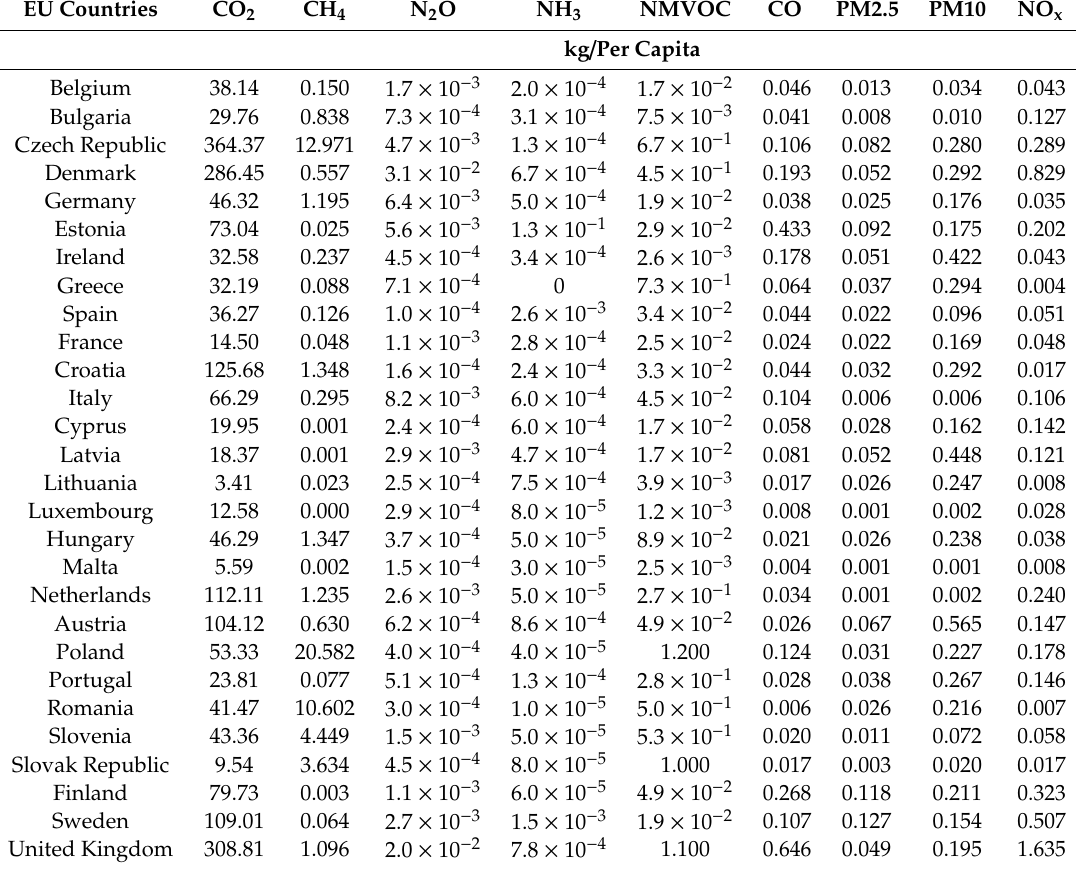
Table 3. Gas and air pollutant emissions into the atmosphere by the EU countries from the mining and quarrying sector in 2017 compared to the population of individual countries (own elaboration based on data from